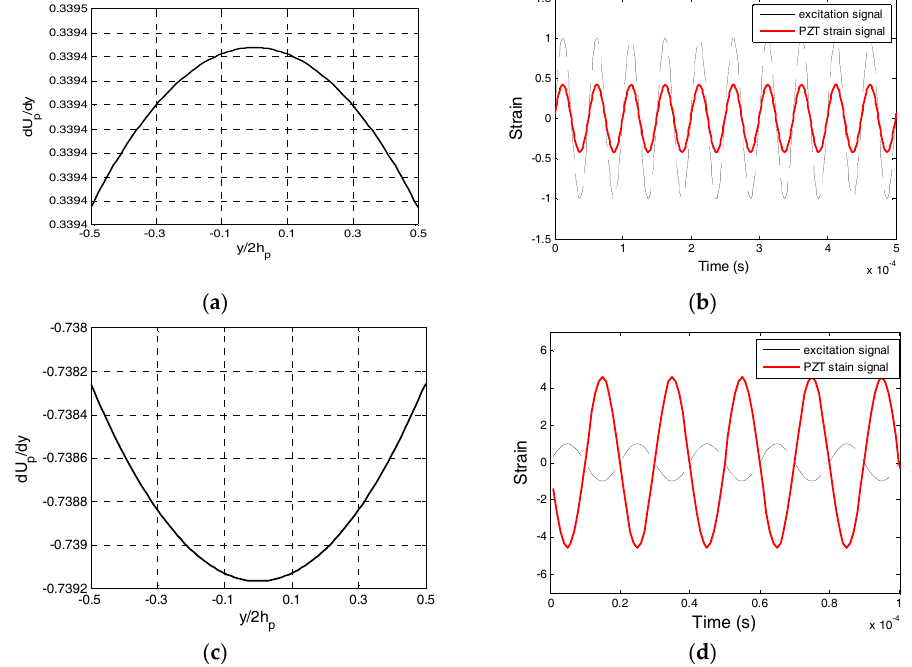
Figure 7. dU p / dy distribution along the y direction, the excitation signal and the PZT strain signal. ( a ) Distribution of dU p /dy when the excitation frequency is 20 kHz; ( b ) PZT strain signal and excitation signal when the excitation frequency is 20 kHz; ( c ) Distribution of dU p /dy when the excitation frequency is 50 kHz; and, ( d ) PZT strain signal and excitation signal when the excitation frequency is 50 kHz.